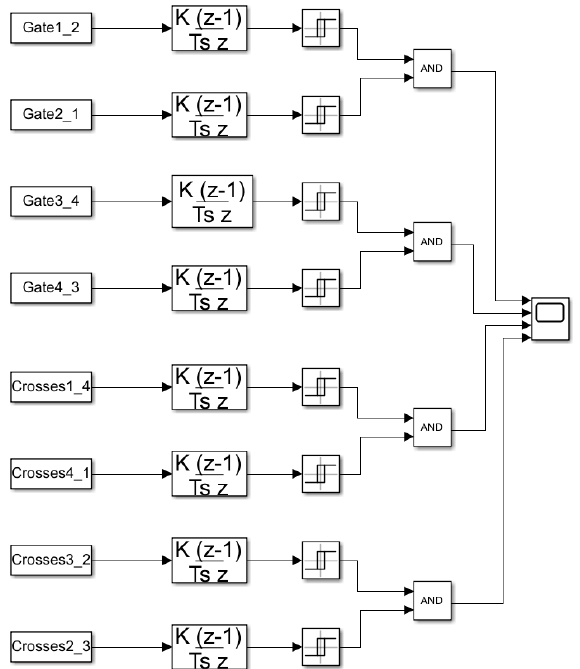
Figure 13. Simulink diagram for derivative data analysis method.